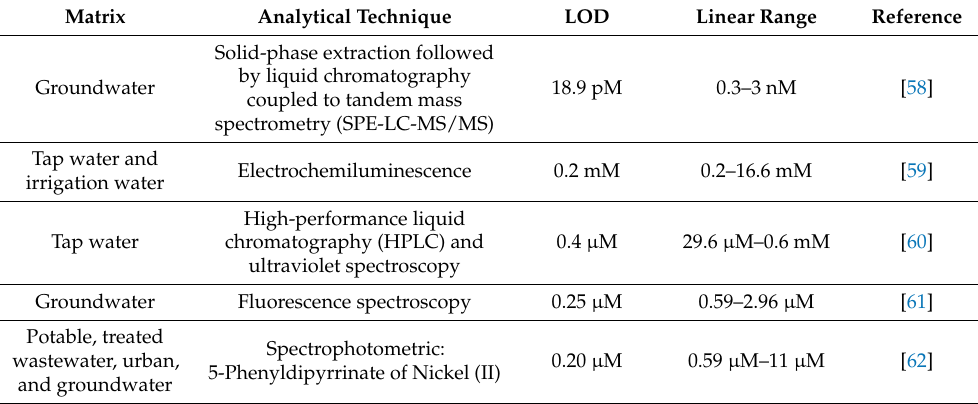
Figure 2. The schematic representation of sensor parts includes recognition elements, transducers, and detectors. Table 1. LOD values of some methods for the detection of GLYP in